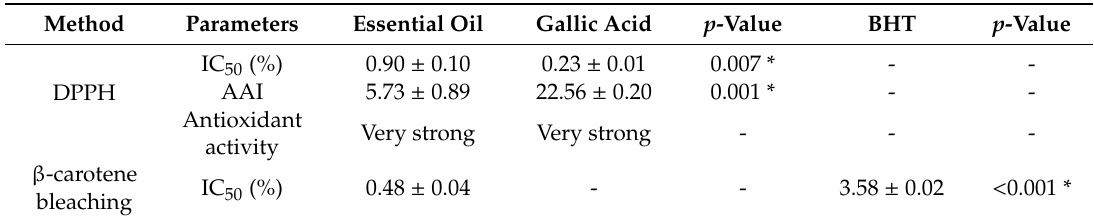
Table 2. Antioxidant properties of rockrose